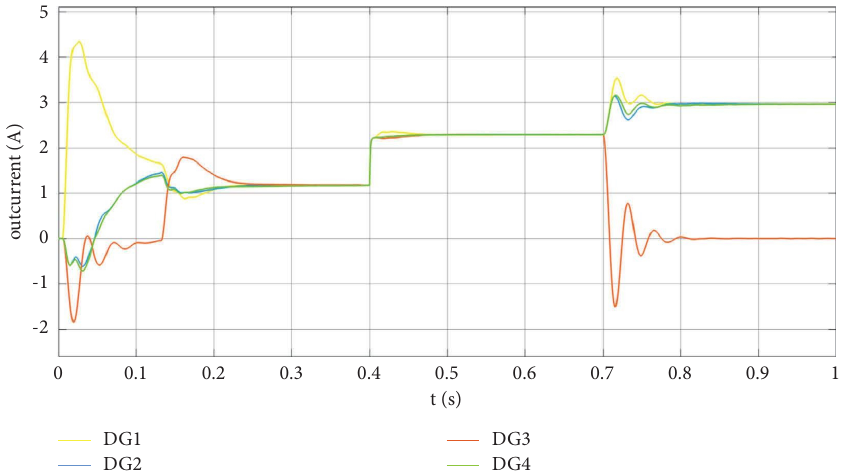
Figure 17: Output current with the scheme in [16].